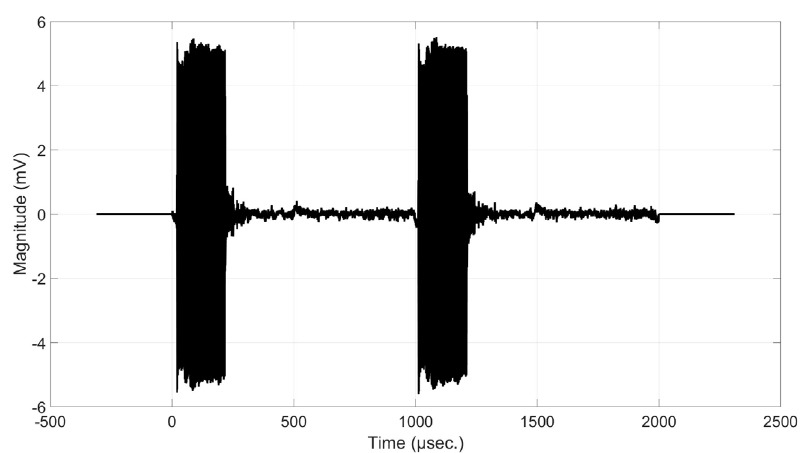
Figure 5. Example of RF-signal recorded by the hydrophone at z f = 28 mm. Con fi guration: 1 MHz-transducer , high water level , vertical position of the hydrophone